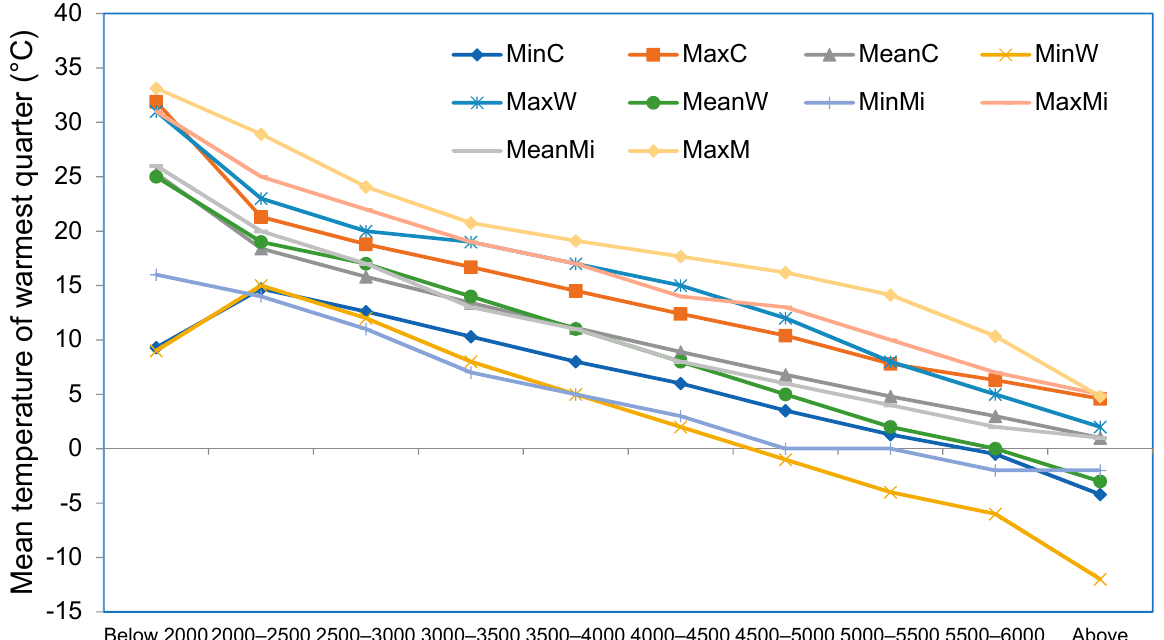
Figure 13. Minimum, maximum and mean values of mean temperature of warmest quarter (BIO10) obtained for each elevation section using WorldClim 2.0, CHELSA and MIROC climate dataset. Here, MinC, MaxC and Mean C represent minimum, maximum and mean values of mean temperature of warmest quarter obtained for each elevation section using CHELSA. Similarly, MinW, MaxW and MeanW represent minimum, maximum and mean values of mean temperature of the warmest quarter obtained for each elevation section using WorldClim 2.0. Correspondingly, MinMi, MaxMi and MeanMi represent minimum, maximum and mean values of mean temperature of warmest quarter obtained for each elevation section using MIROC. Similarly, MaxM represents maximum values of land surface temperature obtained for each elevation section for the period from 2001 to 2017 using MODIS observations.